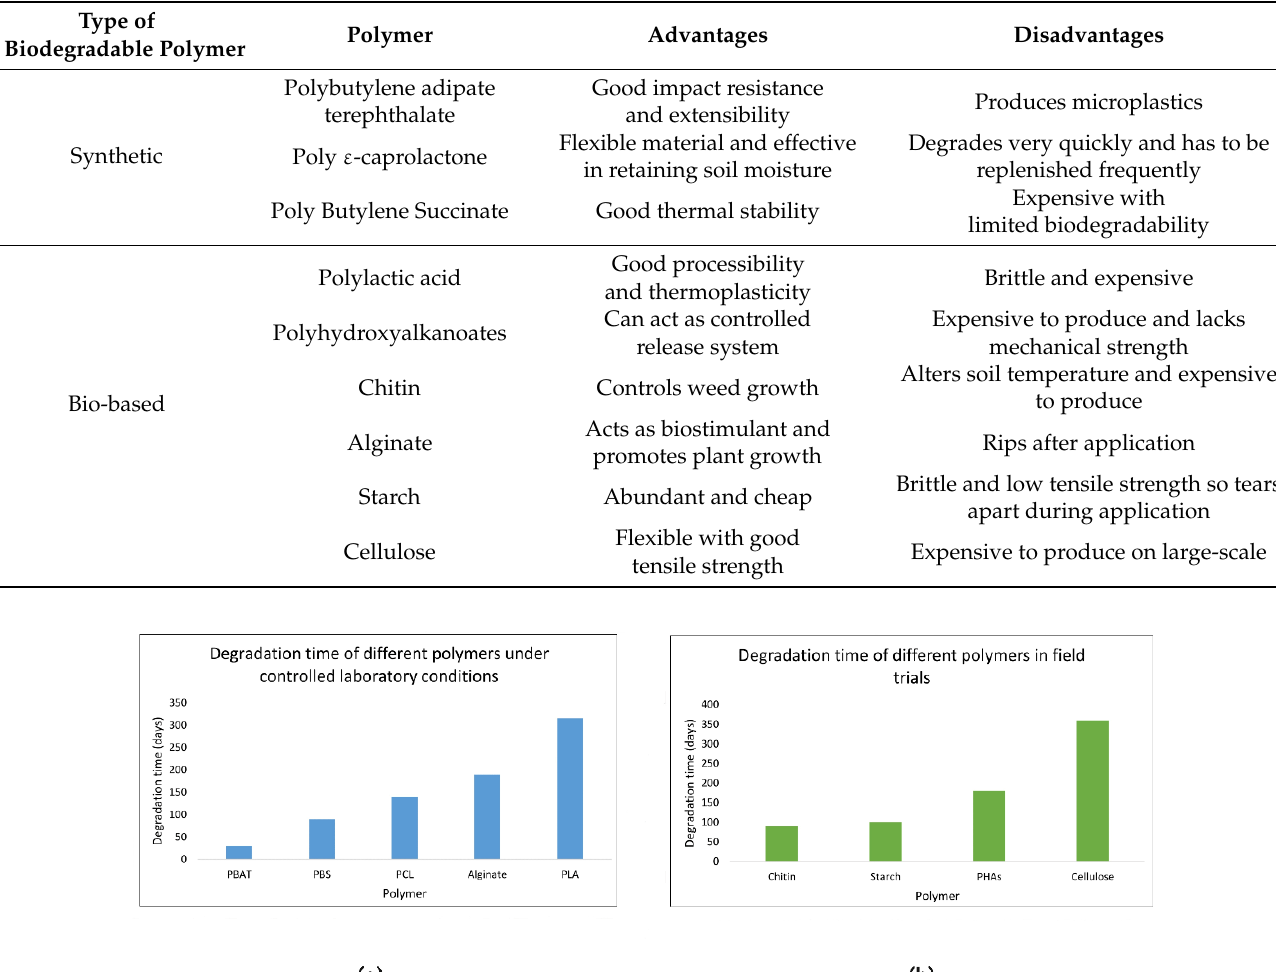
Table 2. Comparison of the advantages and disadvantages of different synthetic and bio-based biodegradable mulch films.